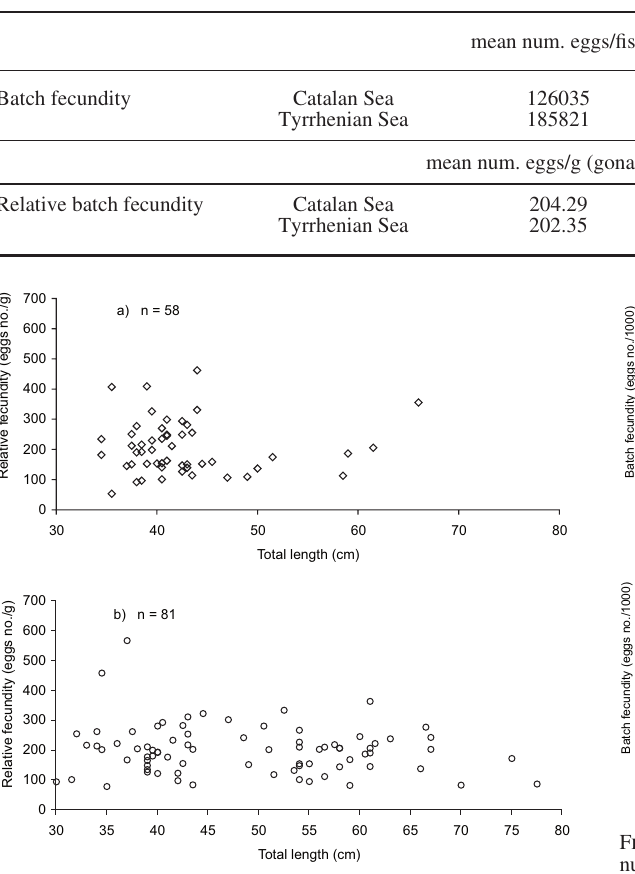
Fig . 10. – Relative fecundity (eggs number/g) of M. merluccius in both areas. a) Catalan Sea; b) Northern Tyrrhenian Sea.